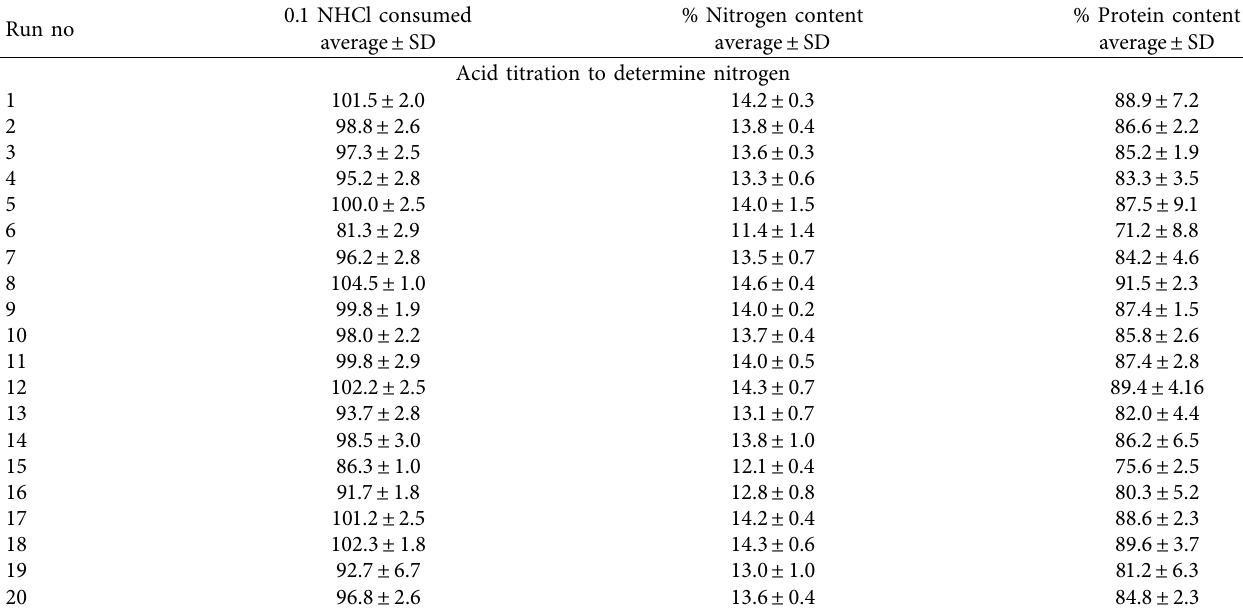
Table 3: Total nitrogen and protein content determination using the Kjeldahl